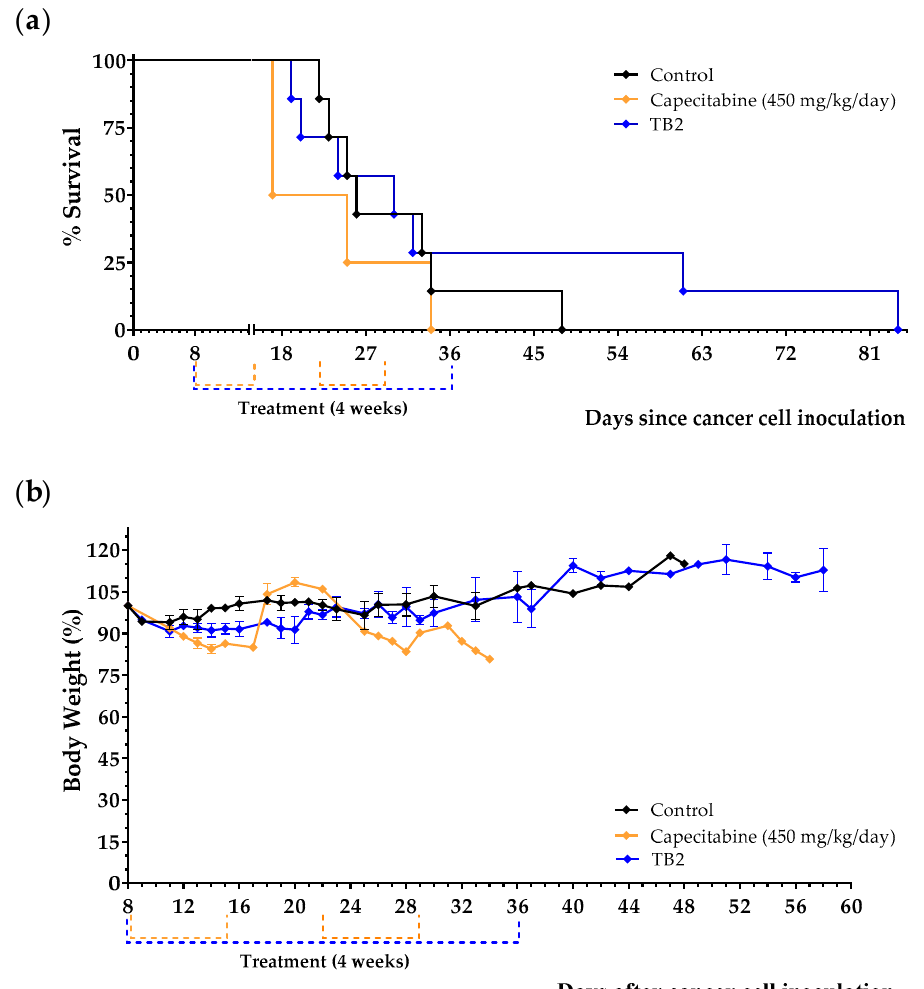
Figure 5. Anticancer effect of diet TB2 and capecitabine in mice with metastatic TNBC. Survival ( a ) and body weight ( b ) of mice treated with diet TB2 (normal diet was replaced by TB2 for 28 days) or with capecitabine (450 mg/kg/day, 7/7 schedule, 3 cycles). Treatments started 8 days after cancer cell inoculation. Body weight are expressed as percentage relative to the body weight at the beginning of the treatments (day 8). See Table 2 for the composition of the diets and the main text for further details. Data are from two independent experiments. The two mice fed diet TB2 that lived longer are from the same experiment.